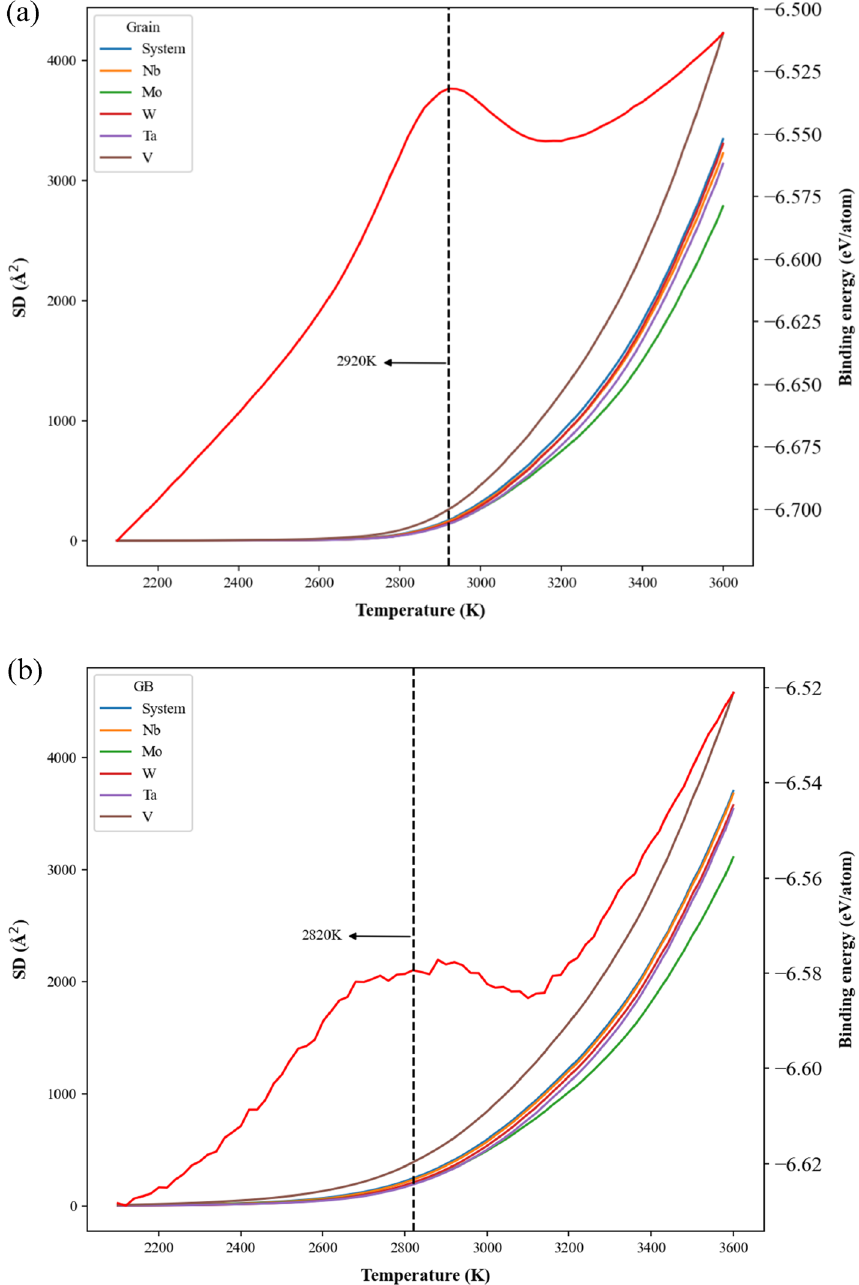
Figure 11. The binding energy and square displacement (SD) profiles of system, Nb, Mo, W, Ta, and V of ( a ) the grain atoms and ( b ) the GB atoms for the case with the average grain size of 25.3 nm during the heating